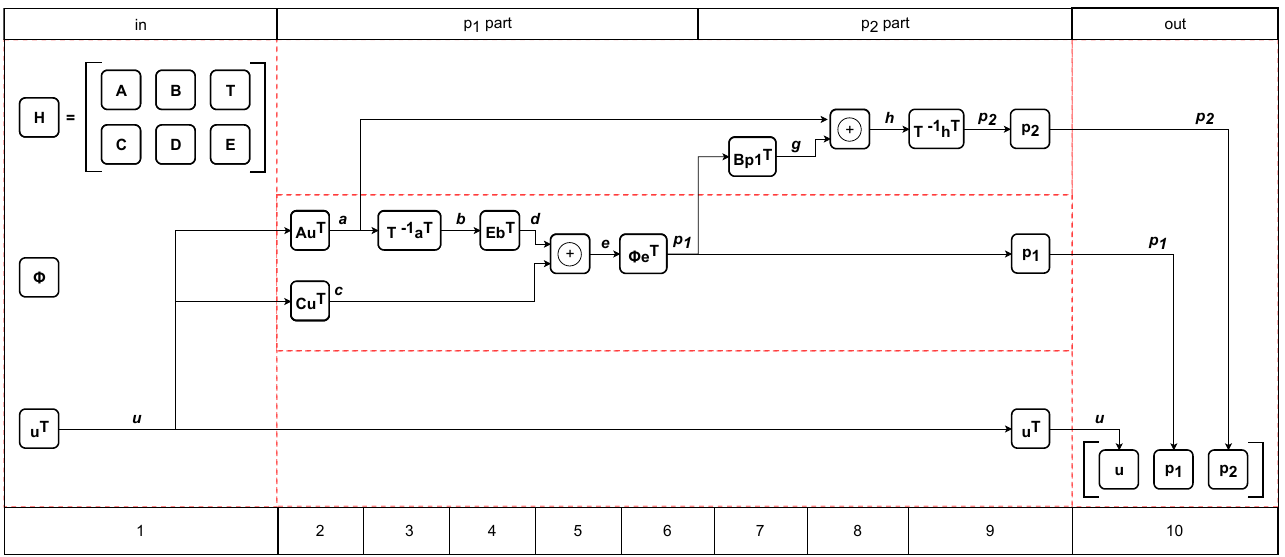
Figure 2. Block diagram presenting consecutive steps in the efficient encoding